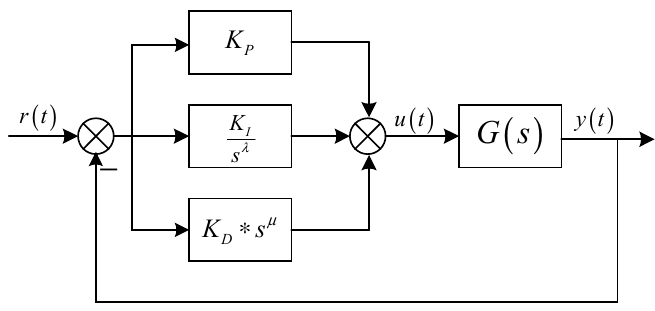
Figure 12. Fractional-order PID control plane diagram. Figure 13 is the FOPID control system model.